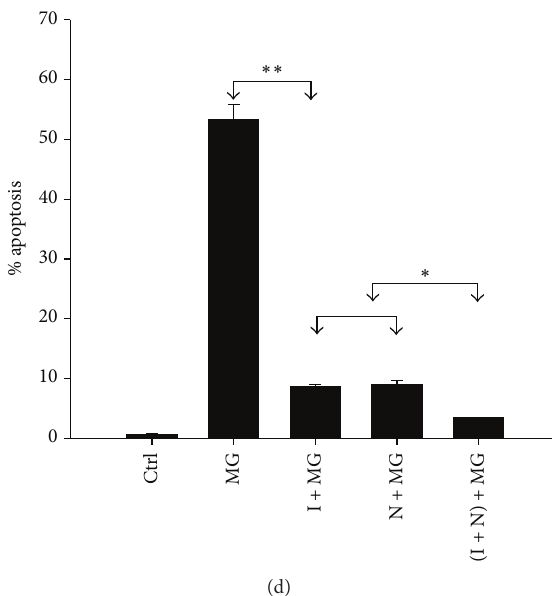
Figure 2: IGF-1 and NAC repress MG132 induced apoptosis. (a) Western blot analysis for two apoptotic markers: cleaved PARP and cleaved caspase 3. Results are representative of three independent experiments. (b) Densitometric analysis from three separate experiments. 𝛽 -Actin served as the loading control. (c) IGF-1 and NAC prevent MG132 induced nuclear morphological changes. Cells were pretreated with IGF-1 (I), NAC (N), or both (I + N) for 18h, followed by treatment with MG132 (MG) (10 𝜇 M) for 24 h, as indicated. The treated cells were then stained with the Hoechst reagent. Nuclear morphological changes were imaged using a confocal fluorescence microscope (arrows denote apoptotic nuclei). The photomicrographs shown are representative of three repeated experiments. (d) Quantification of cells with abnormal nuclei. Values are mean ± SEM ( 𝑛 = 3 ) ( ∗ 𝑝 ≤ 0.05 , ∗∗ 𝑝 ≤ 0.005 ).